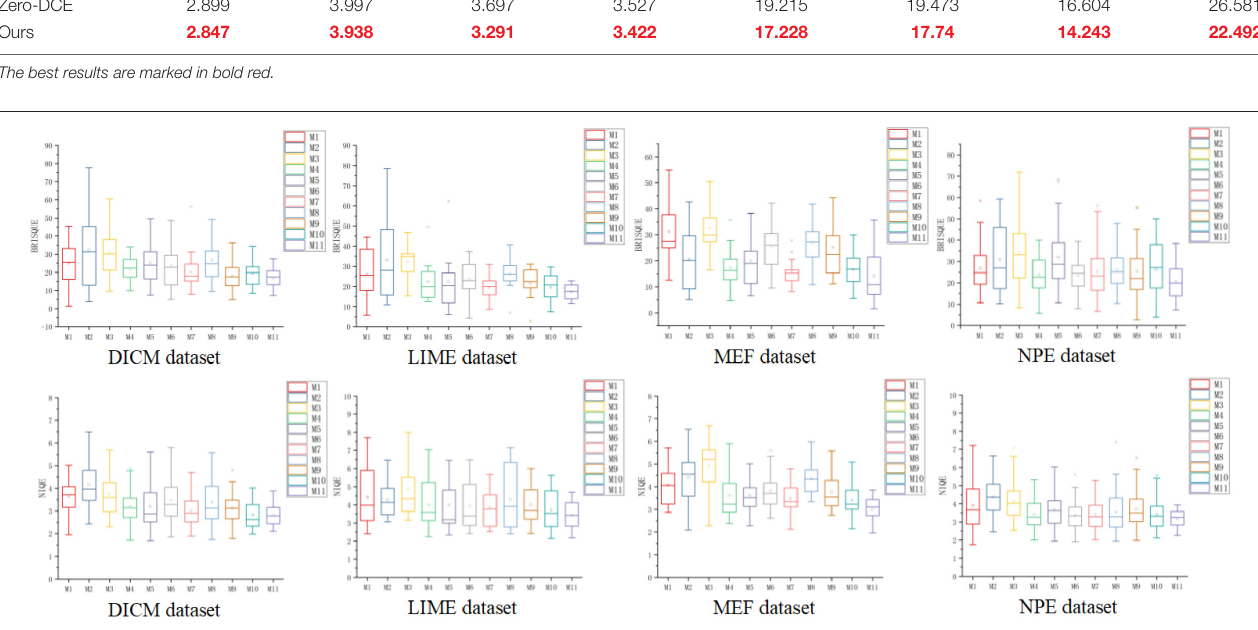
FIGURE 12 | The results of the different low-light enhancement methods were calculated using BRISQUE and NIQE evaluation metrics in a total of four public datasets, DICM, LIME, MEF and NPE. The calculated results are compared quantitatively using box-line plots. The shorter the length of the box line plot, the more stable the method is and the better the enhancement effect.